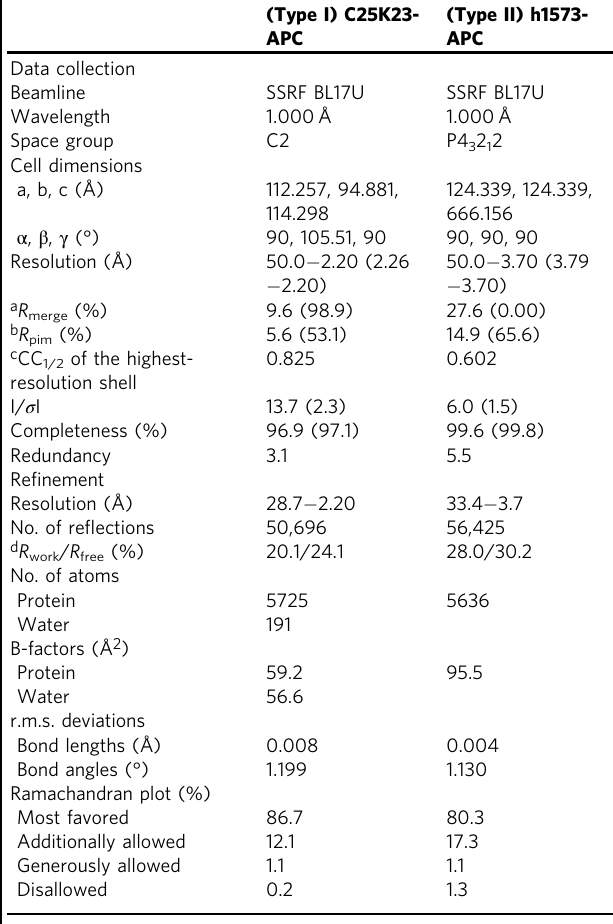
Table 1 Diffraction data collection and structural re fi nement